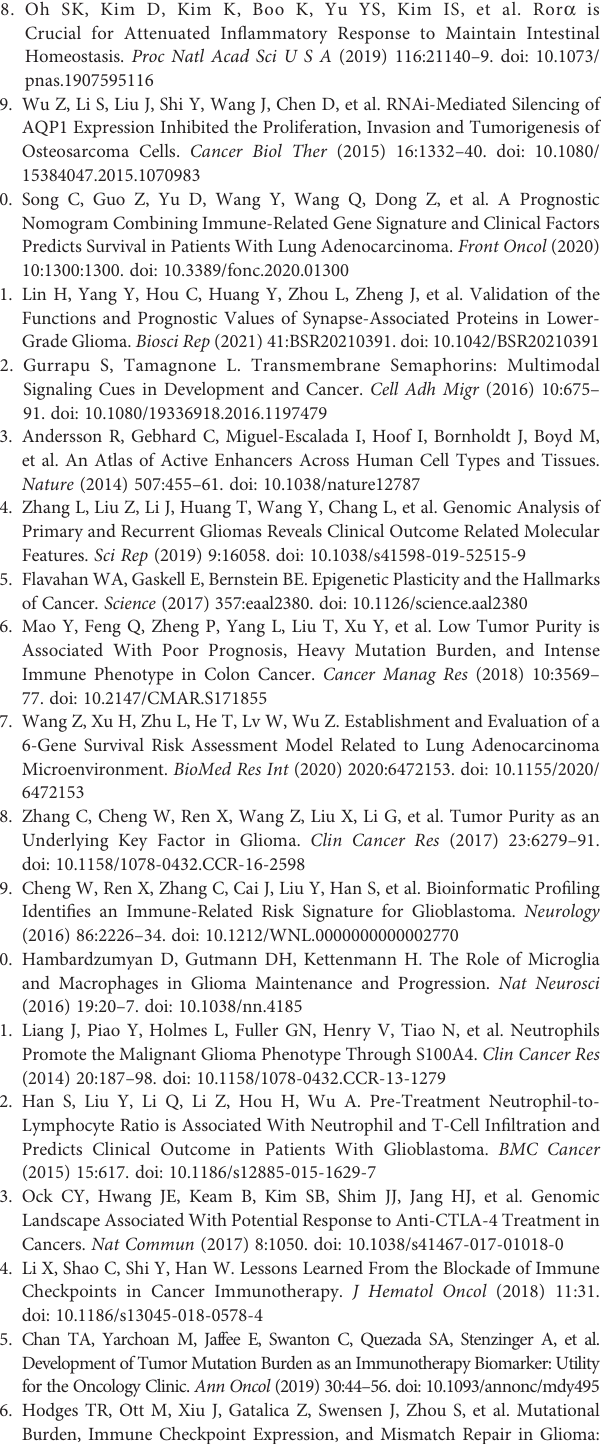
Supplementary Table 7 | The GSEA results in the negative correlative group. Supplementary Table 8 | The Cox analysis for all prognostic